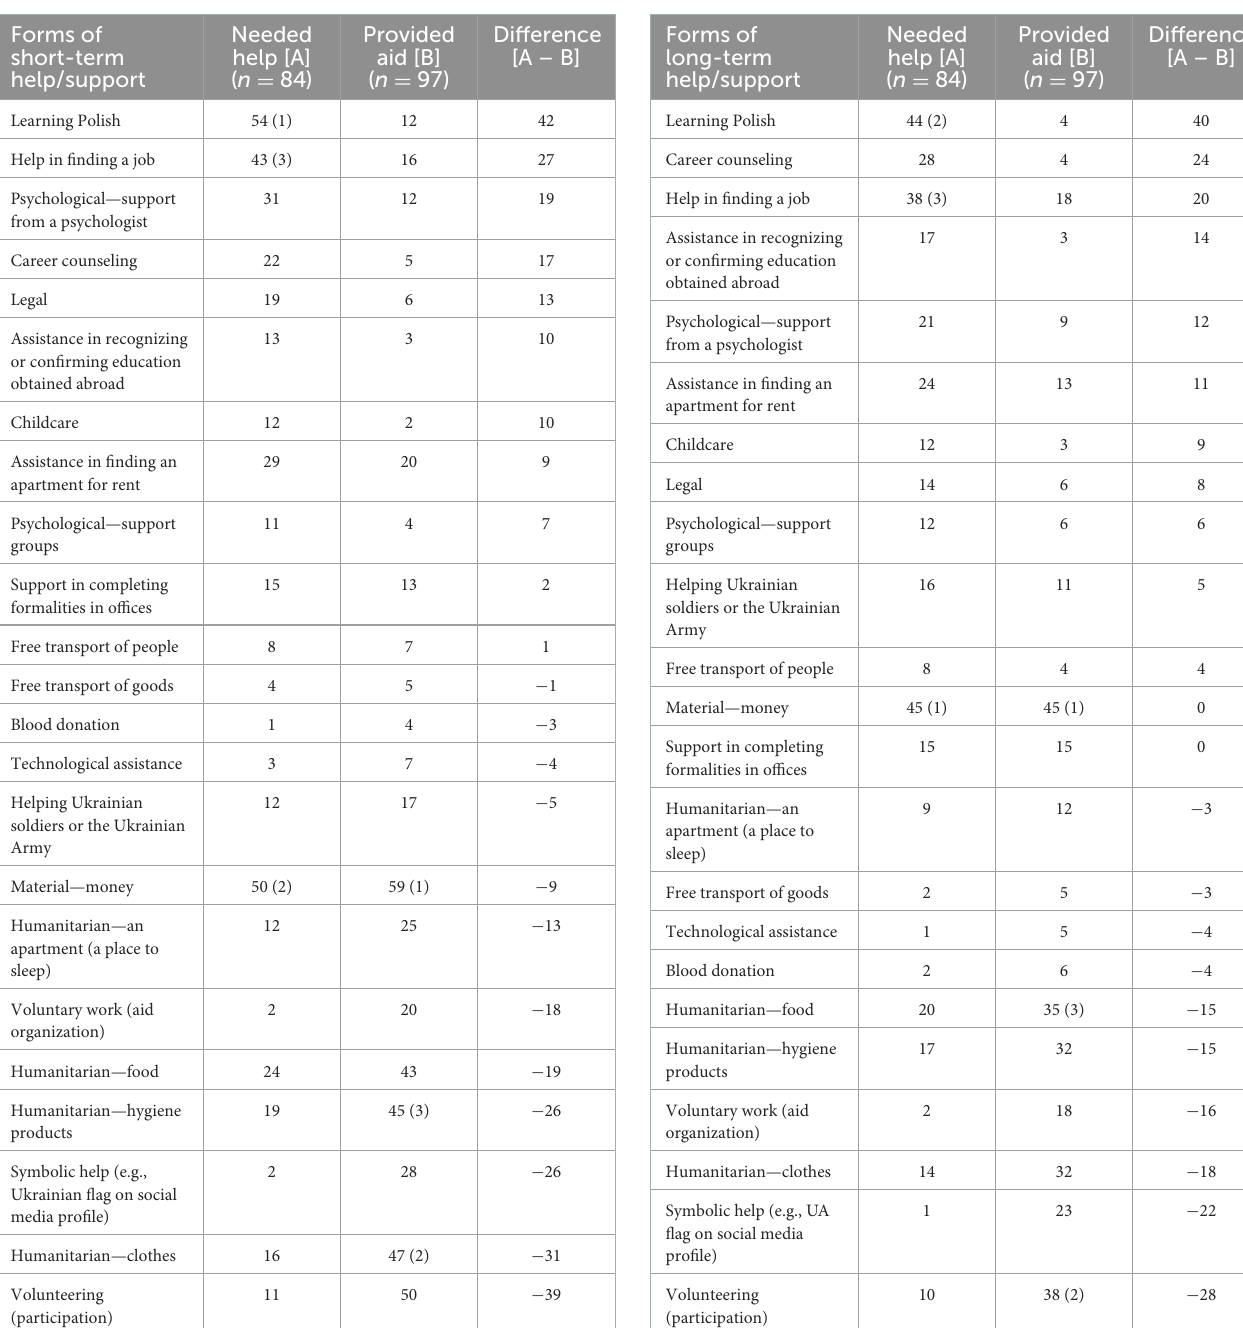
TABLE 6 Forms of short-term aid from the perspective of the needs of refugees, the aid provided by supporters, and the difference between them.